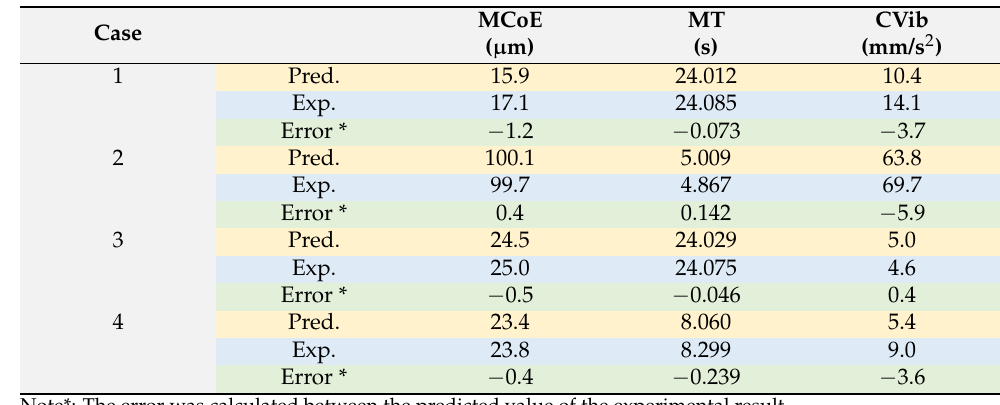
Table 6. Artificial neural network (ANN)-predicted and experimental results for MCoE, MT, and